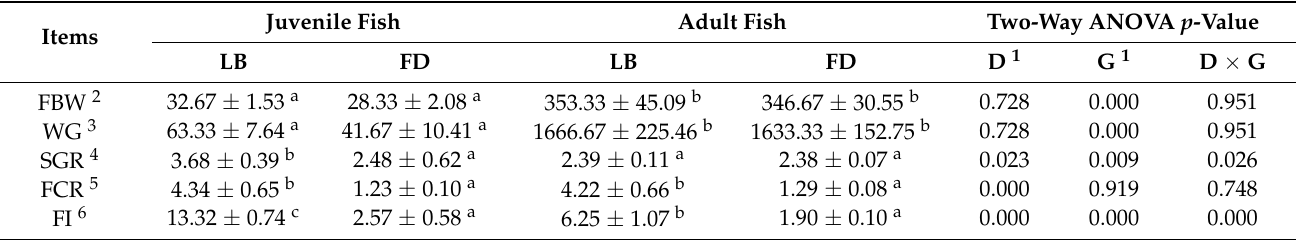
Table 3. Effects of live baits and formulated diet on the growth performances of Siniperca chuatsi at different growth stages 1